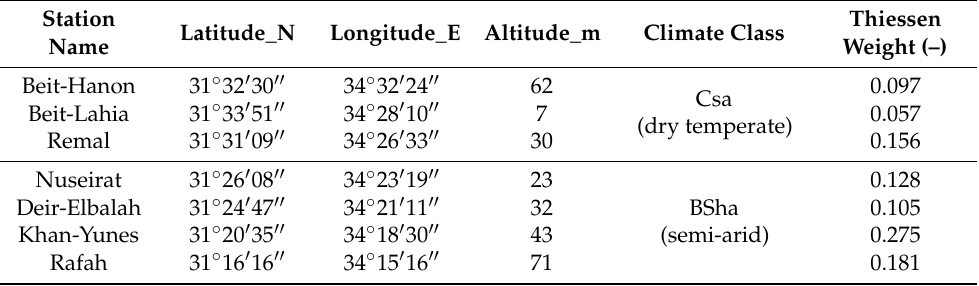
Table 1. Meteorological stations in Gaza and climate classes according to Köppen-Geiger clim- ate